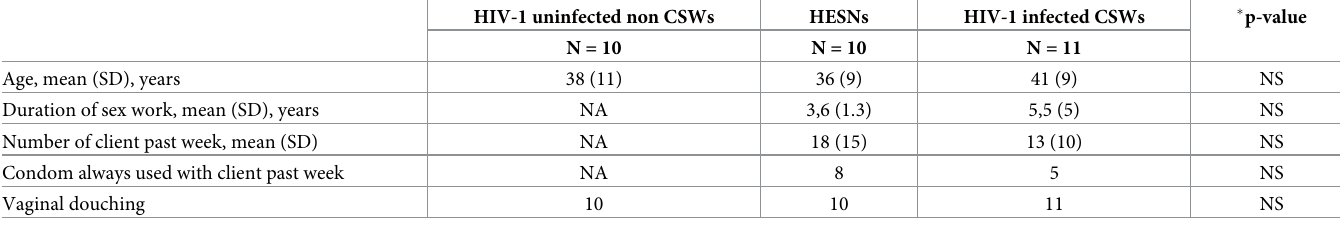
Table 1. Distribution of demographic and sexual behavior characteristics in HIV-1 uninfected non-CSW, HESN and HIV-1 infected CSW